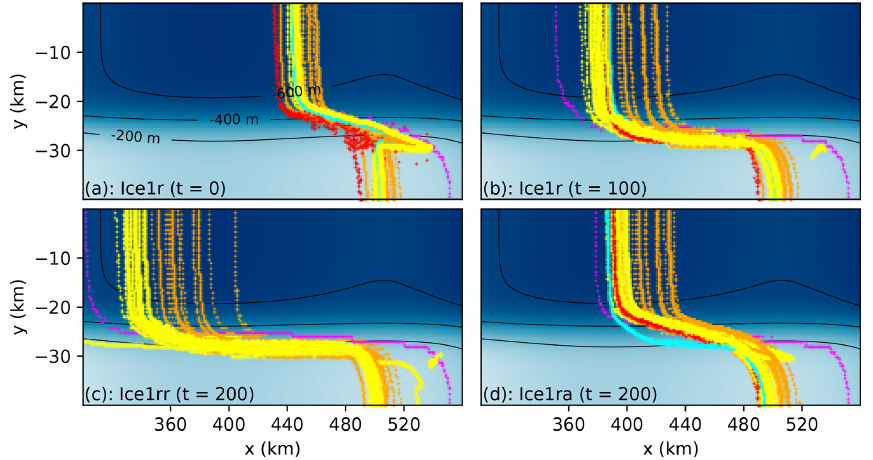
Figure 4. Grounding line migration for all models with (cid:49)x ≤ 1km in the Ice1 experiments. The Ice1r experiment starts from the Ice0 steady- state position at t = 0a (a) . Grounding lines migrate upstream while the melt rate of Eq. (7) is applied until t = 100a (b) . There are two branches for t > 100a: the Ice1rr branch which continues with the same melt rate (c) and the Ice1ra branch with zero melt rate (d) . Yellow contours correspond to SSA, L1Lx, and HO models with the Coulomb-limited basal friction law; orange contours to SSA, L1Lx, and HO models with the Weertman basal friction law; red (ISSM) and cyan (Elmer/Ice) contours to full-Stokes models; and magenta contours to HySSA models. The color map and black contours depict bedrock